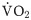
Relationship between Δ[O2HbMb-HHbMb]-BP and VT1.Δ[O2HbMb-HHbMb]-BP and VT1 are moderately related for V˙O2 (a) en PO (b). Individual values are shown for male cyclists (closed triangle), female cyclists (closed circle), endurance trained males (open square), recreationally trained males (open triangle). The thick solid line represents the best linear fit obtained from individual data at Δ[O2HbMb-HHbMb]-BP and VT1 and the dotted line represents extrapolation of this best linear fit. The thin solid line is the line of identity.